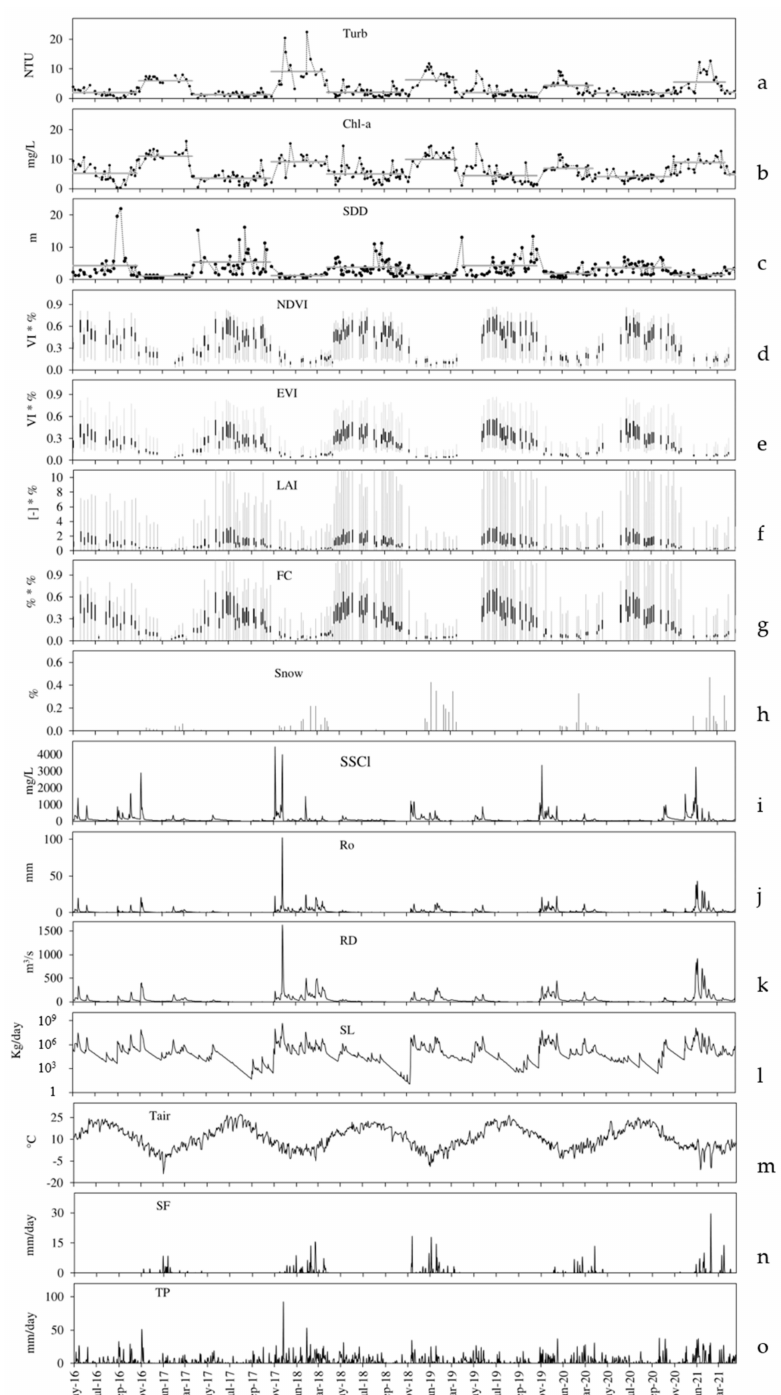
Figure 4. Temporal series of water, land, meteorological, and hydrological parameters inside the Banja watershed for the period 7 May 2016–24 April 2021. ( a – c ) spatial average values within the central polygon inside the Banja reservoir (Figure 1). ( d – g ) spatial statistics over the vegetation class within the Banja watershed weighted for the percentage of the vegetation cover. Boxplots show 25th to 75th quantile in black and minimum/maximum values in grey. ( h ) snow cover within the watershed. ( i – l ) hydrological parameters derived as in Section 2.2.4; note that SL is plotted with a log10 scale for visualization reasons. ( m – o ) spatial mean values of the ERA5-Land grid falling within the Banja